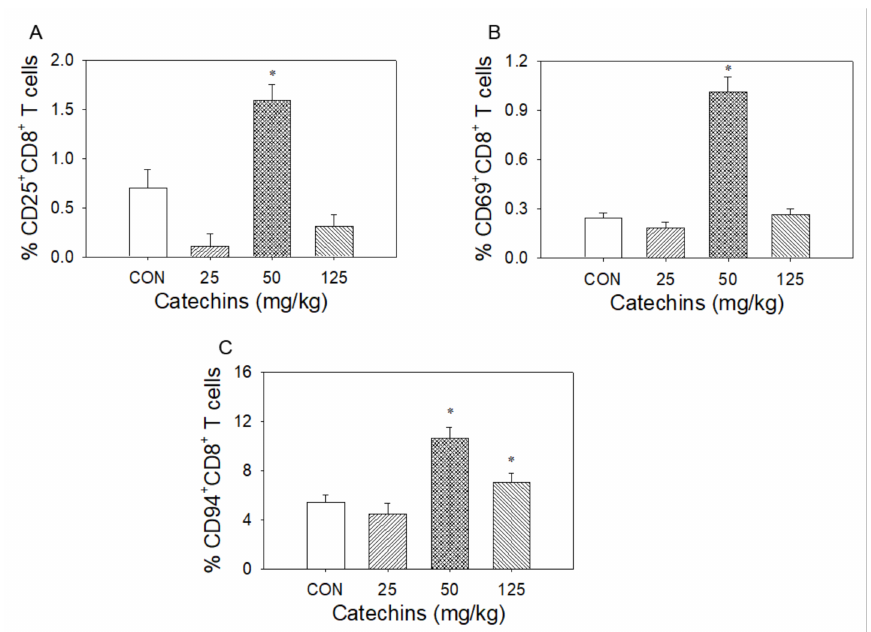
Figure 5. Effect of four weeks of dietary catechins on CD25/CD69/CD94-NKG2A signaling in mice splenic CD8 + T lymphocytes. After 4 weeks of catechins ingestion, the percentage change of CD25 ( A ), CD69 ( B ) and CD94-NKG2A ( C ) splenic CD8 + T lymphocytes is noted in mice. Using flow cytometry assay, catechins treatment significantly increased percentage of CD25, CD69, and CD94-NKG2A receptor expression in splenic CD8 + T lymphocytes primarily at the dosage of 50 mg/kg; * p < 0.05 vs. control (0